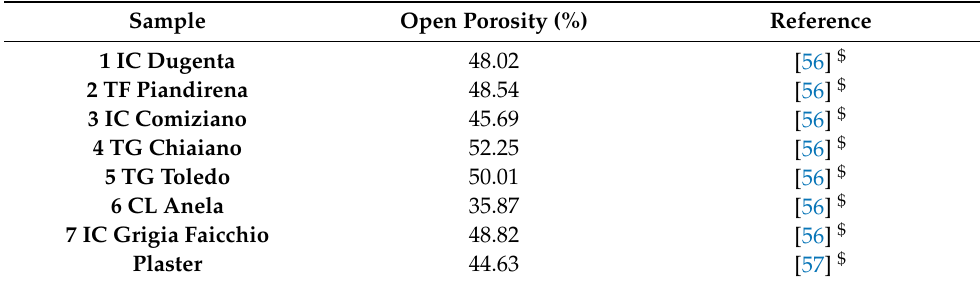
Table 3. Open porosity (P) of the various rocks and